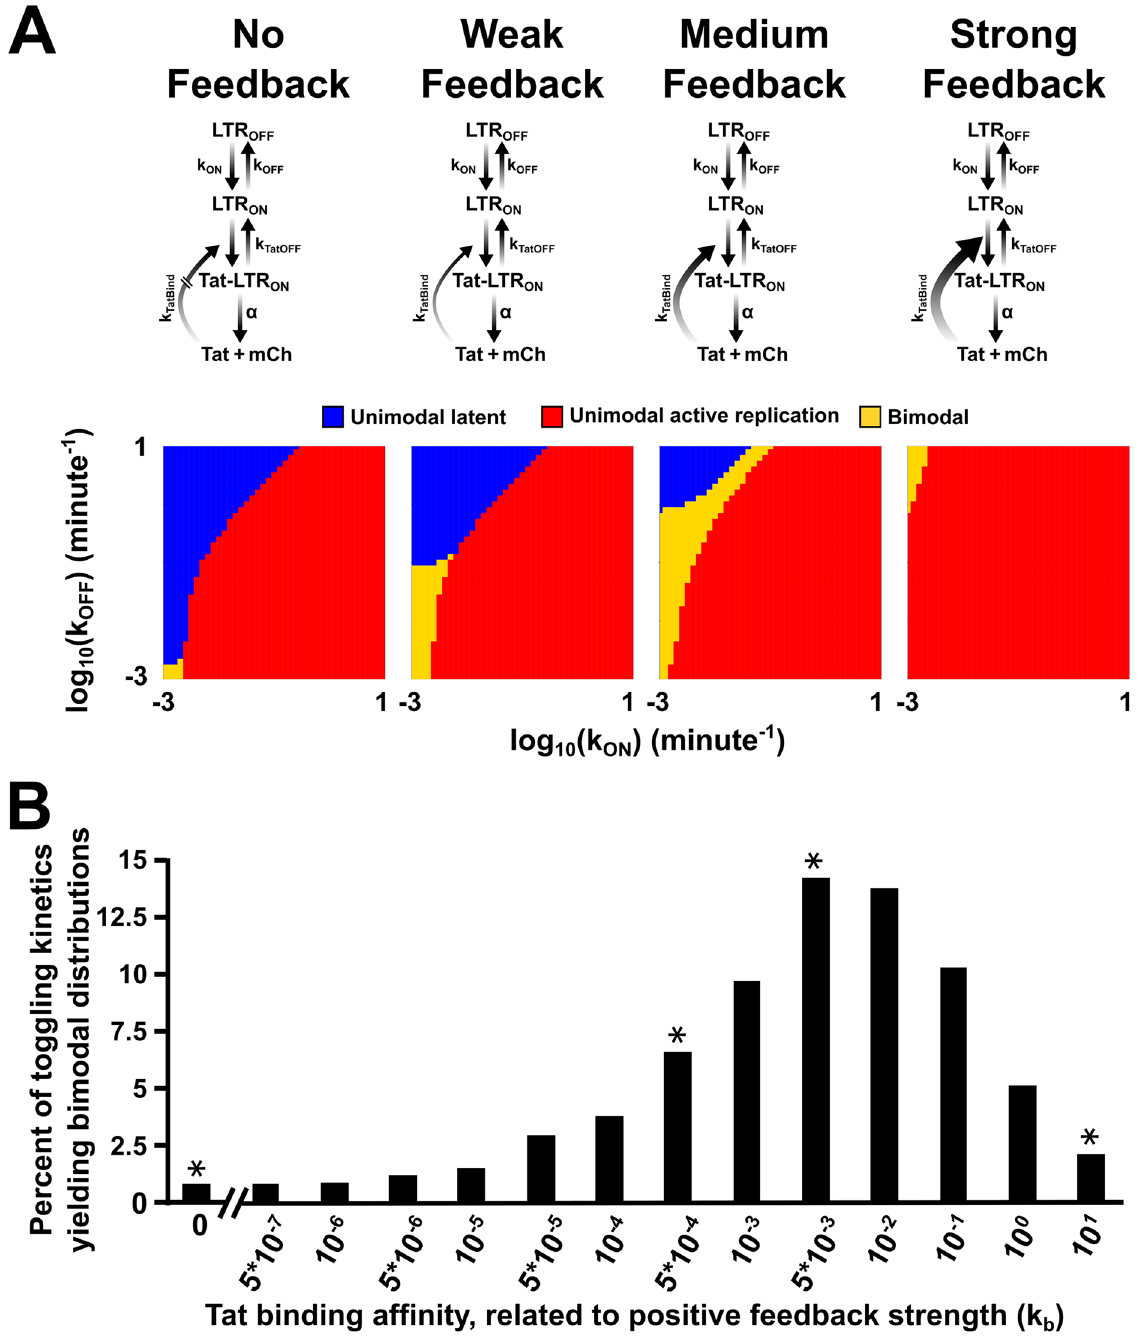
Fig 4. HIV positive feedback appears optimized to robustly generate bimodal distributions. (A) Varying the positive- feedbackstrength changesthe togglingkinetics to yield a larger regime for bimodality within the physiological parameter range. The results for the parameter scans are shown for “No Feedback” (left) and increasing feedbackstrengths. Whether a population was unimodal latent (blue), unimodal active replication (red), or bimodal(orange) was determined for each set of parameters as describedin the Materials and methods section. For the modality analysis, each mode was requiredto contain at least 0.1% of the population. (B) The percent of togglingkinetics that yield bimodaldistributionsfor varying feedbackstrengths. The asterisks above the bars represent the feedbackstrengths shown in (A) (S35